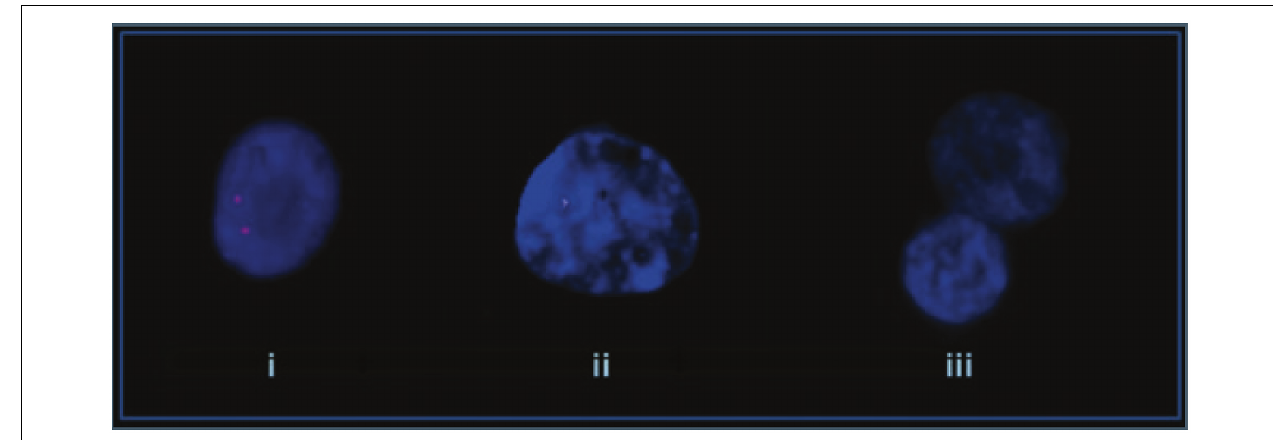
FIGURE 3 | Molecular cytogenetic analyses of normal control and schizophrenia affected patients. (i) Normal control, (ii) mono-allelic deletion, and (iii) bi-allelic deletion (LoVasco etal.,